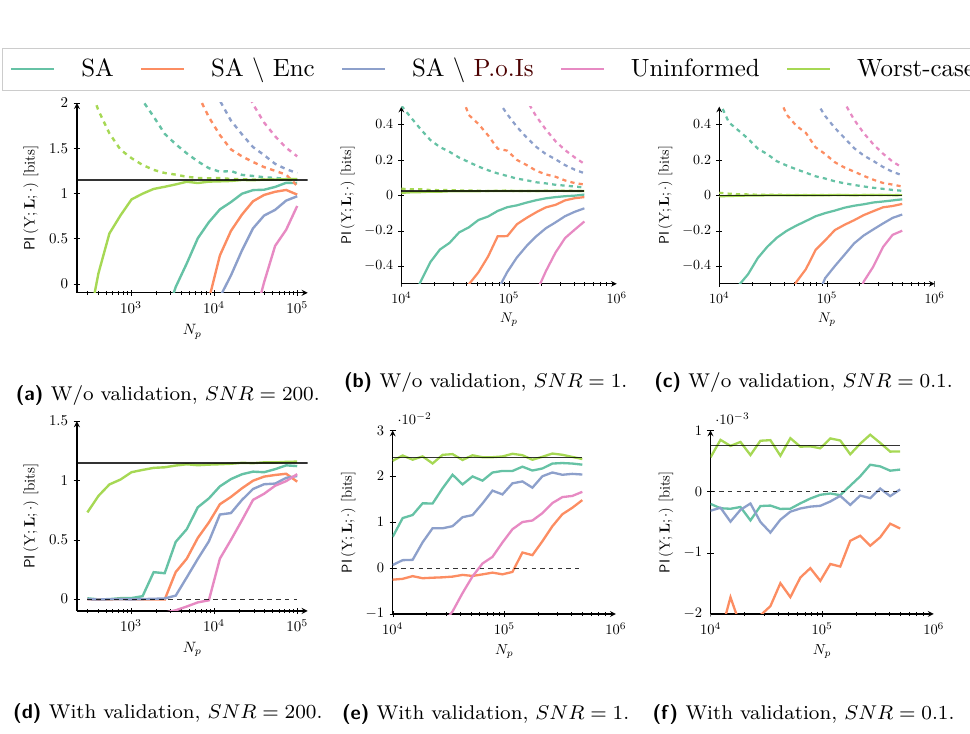
Figure 4: Learning curves for models against a first-order Boolean